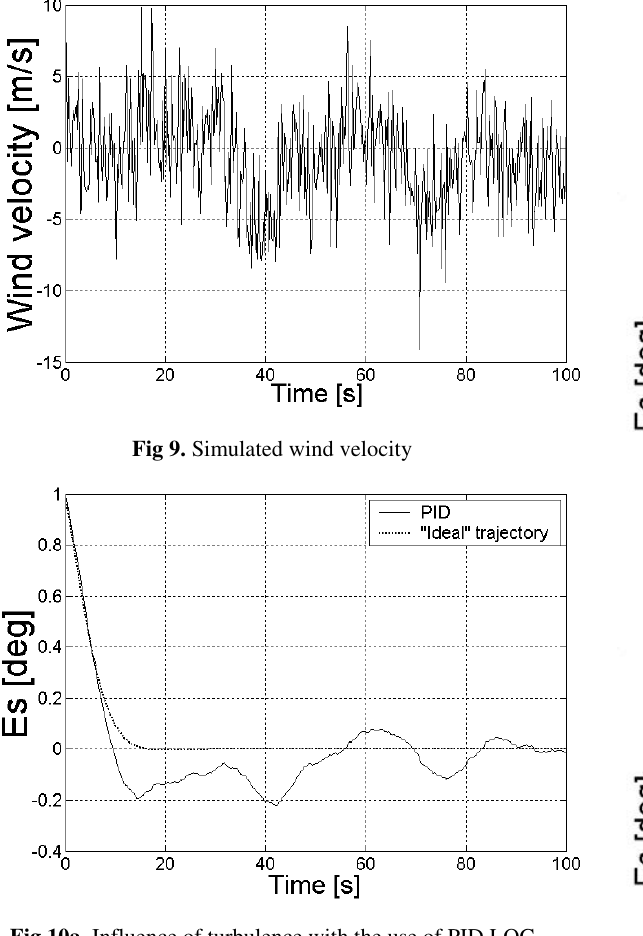
Fig 10a. Influence of turbulence with the use of PID LOC controller